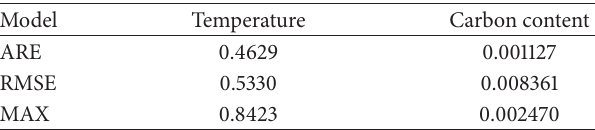
Table 7: The results for ARE, RMSE, and MAX of temperature and carbon content.